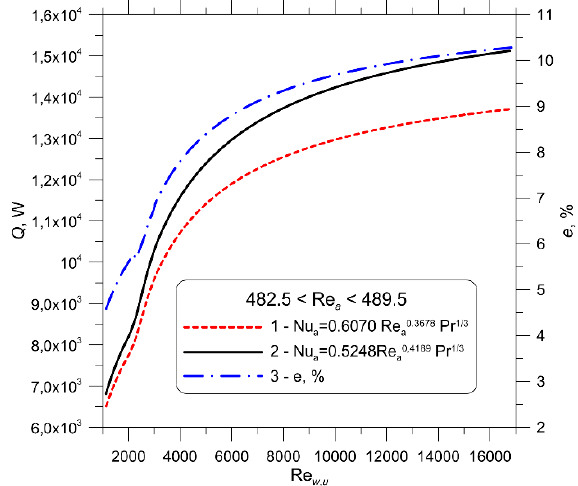
Figure 8. The heat flow rate Q t ,1 HTC from water to air in an engine cooler constructed from round tubes with an equal HTC on the air side of the entire radiator versus the first-pass Reynolds number Re w , u on the water side; 1: air-side correlation for Nu a based on CFD modelling, 2: air-side relationship for Nu a based on experimental data, 3: relative di ff erence e .